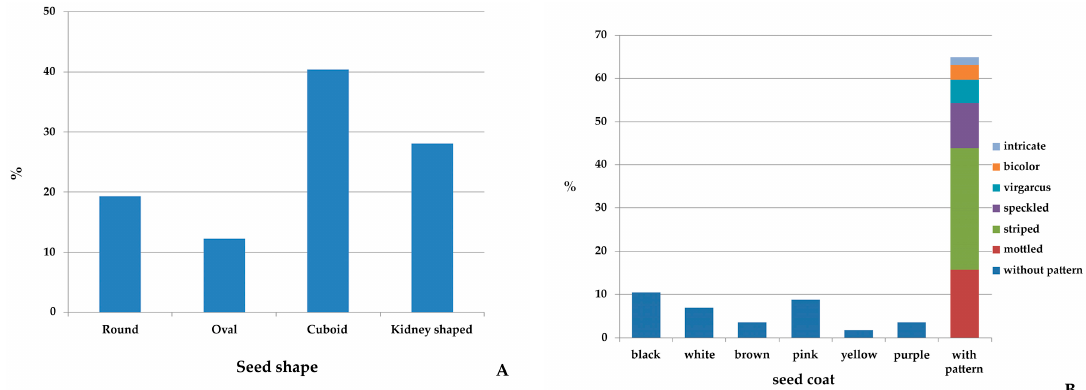
Figure 2. Percentage (%) of seed shape ( A ) and seed coat color and pattern ( B ) recorded on 57 Sicilian common bean landraces. In panel B the different types of seed coat pattern are reported.